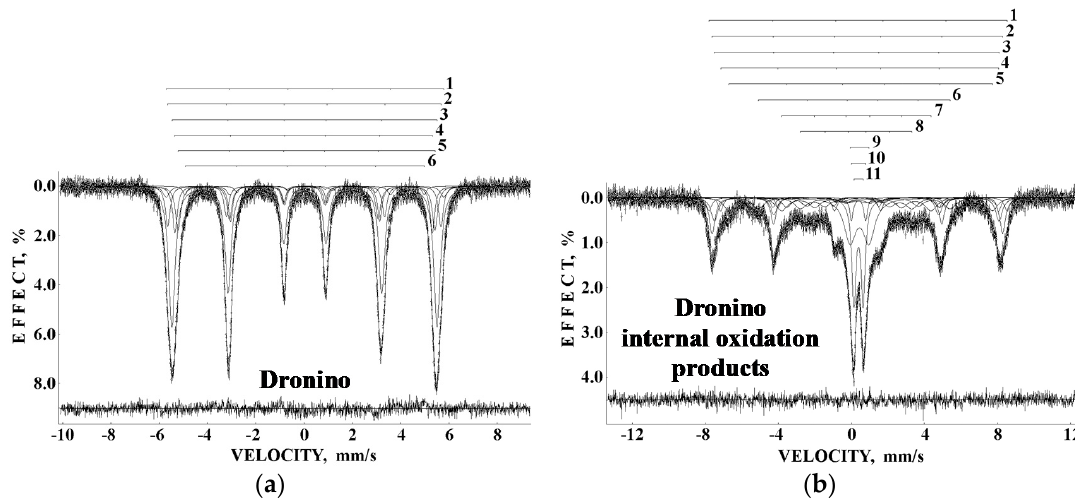
Figure 34. Room temperature 2048-channel Mössbauer spectra of Dronino iron ungrouped meteorite: powdered metallic iron alloy ( a ) and powdered internal oxidized material ( b ). Indicated components are the results of the best fits. The differential spectra are shown on the bottom. Adapted from [83].